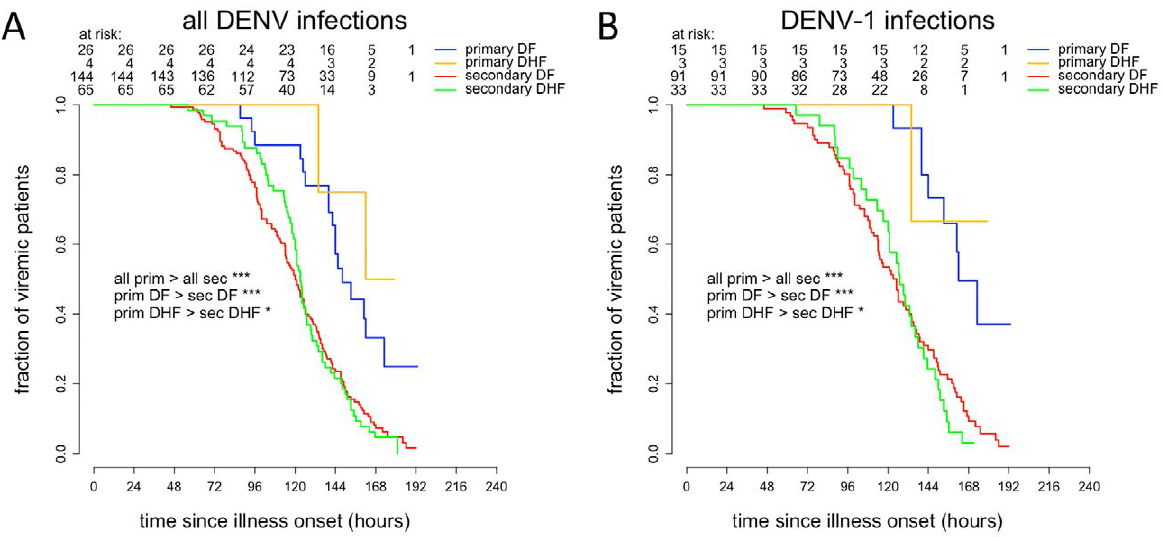
Figure 3. Time to resolution of DENV viremia. Kaplan-Meyer survival analysis of time to resolution of plasma viremia in all viremic A ) or DENV-1 only B ) patients.